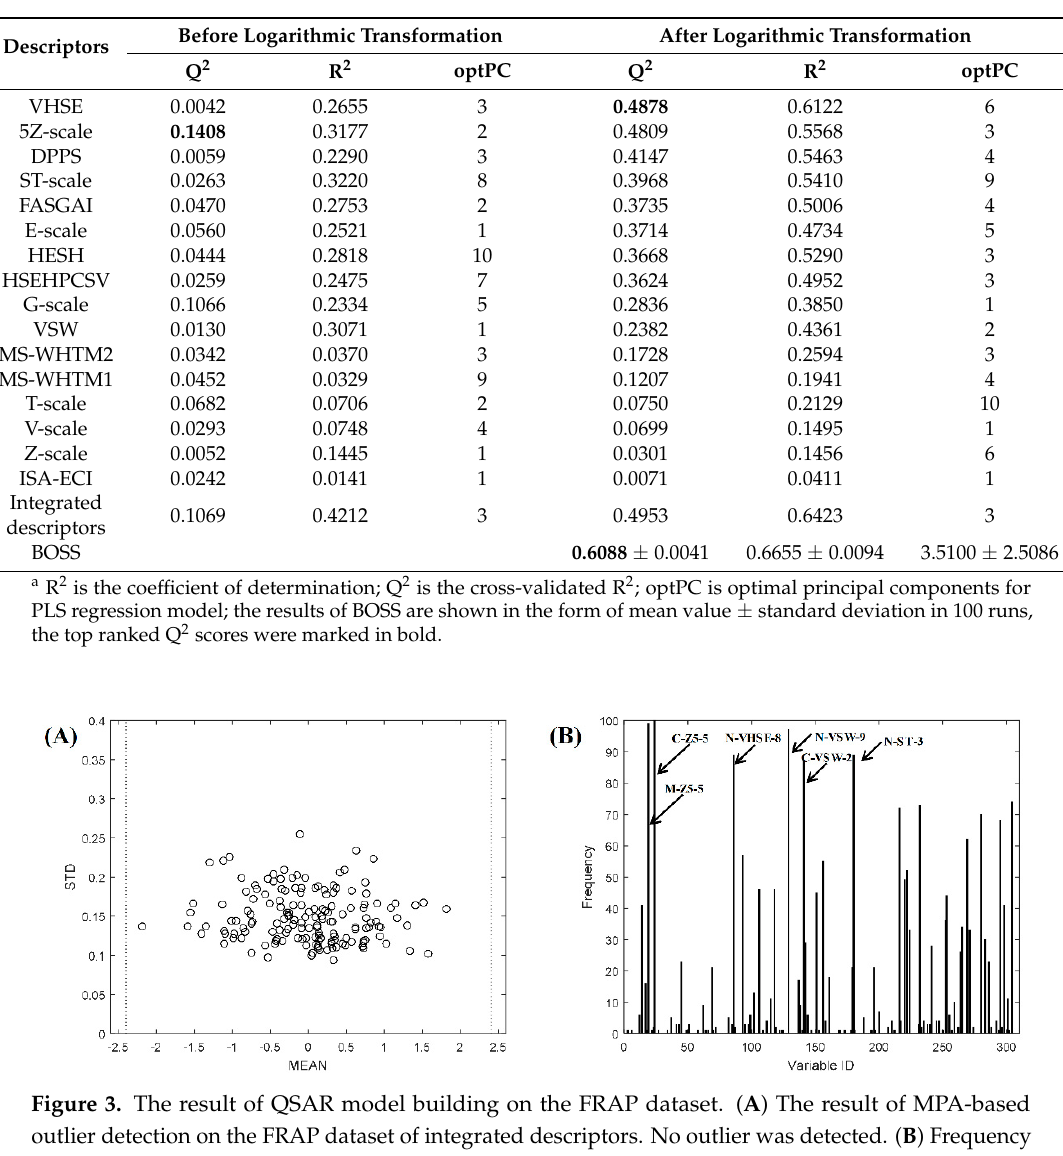
Table 2. Comparisons among different QSAR models on FRAP dataset a .